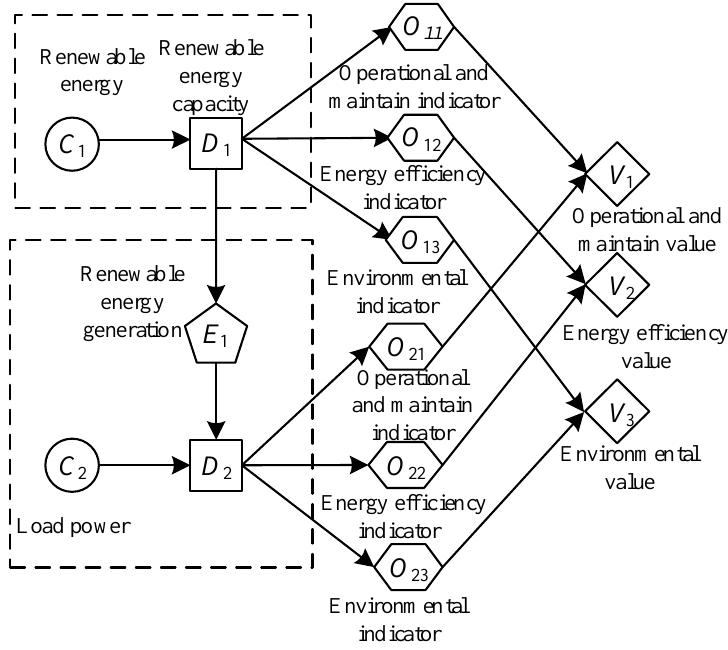
Figure 8. Network structure analysis chart for the decision-making process.